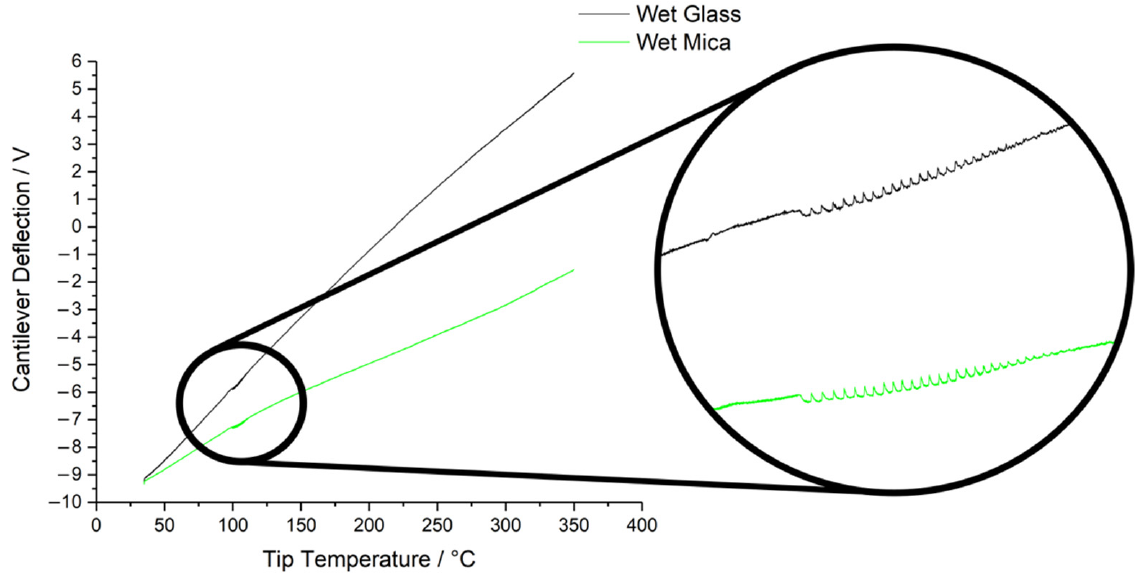
Figure A6. NanoTA profiles of wet glass and wet mica drawn from a clean LB trough showing the water deflection fringes at ~100 °C in the inset.